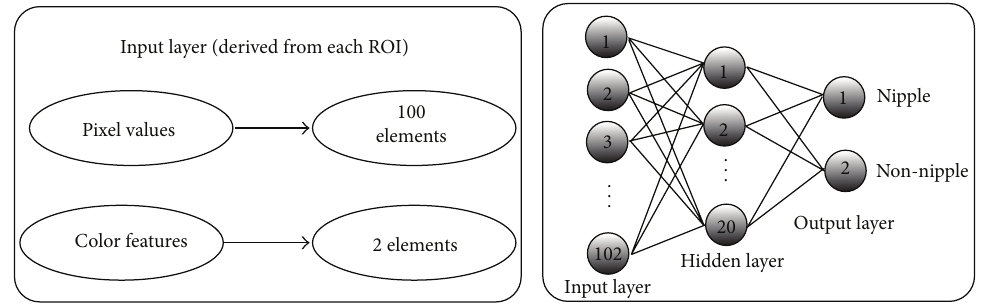
Figure 4: The structure of the neural network for nipple detection.